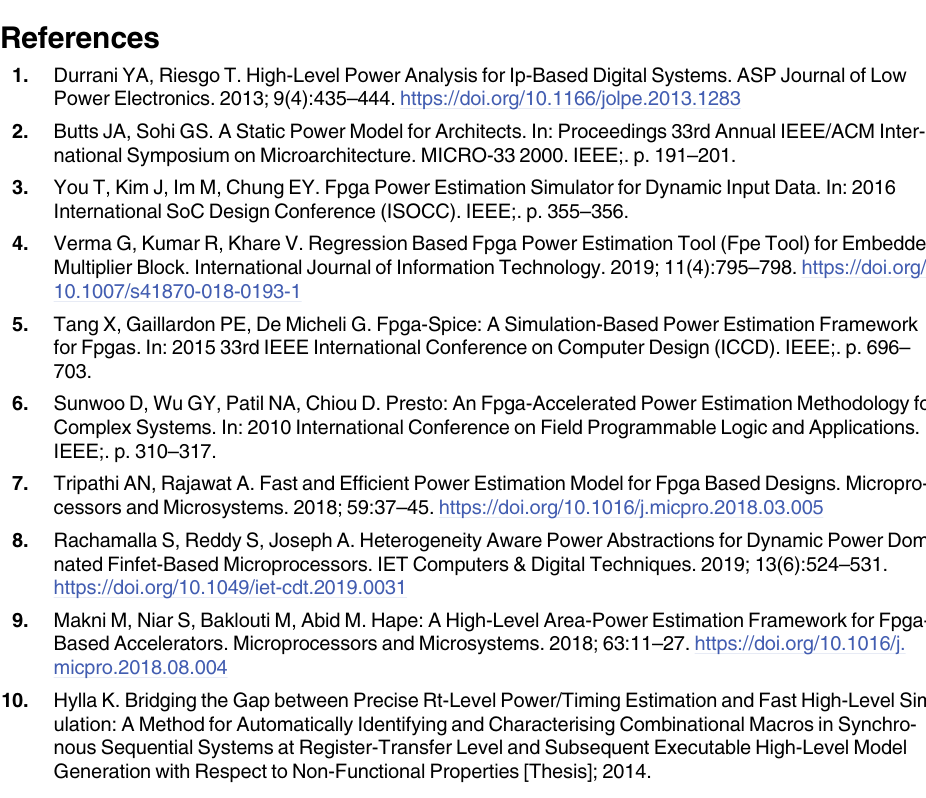
S6 File. Fig 10 plot